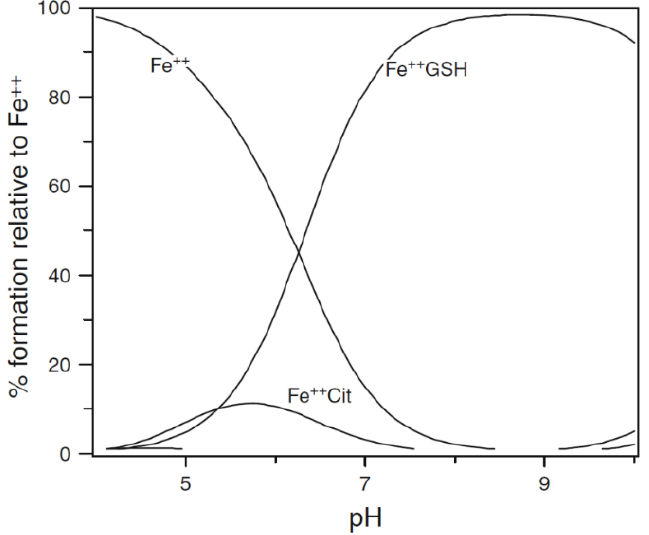
Figure 2. Speciation plot of iron(II) in the presence of cytosolic levels of glutathione and citrate. [Fe 2+ ] total = 1 μM, [Cit] total = 100 μM, and [GSH] = 2 mM. Fe ++ is ferrous iron.